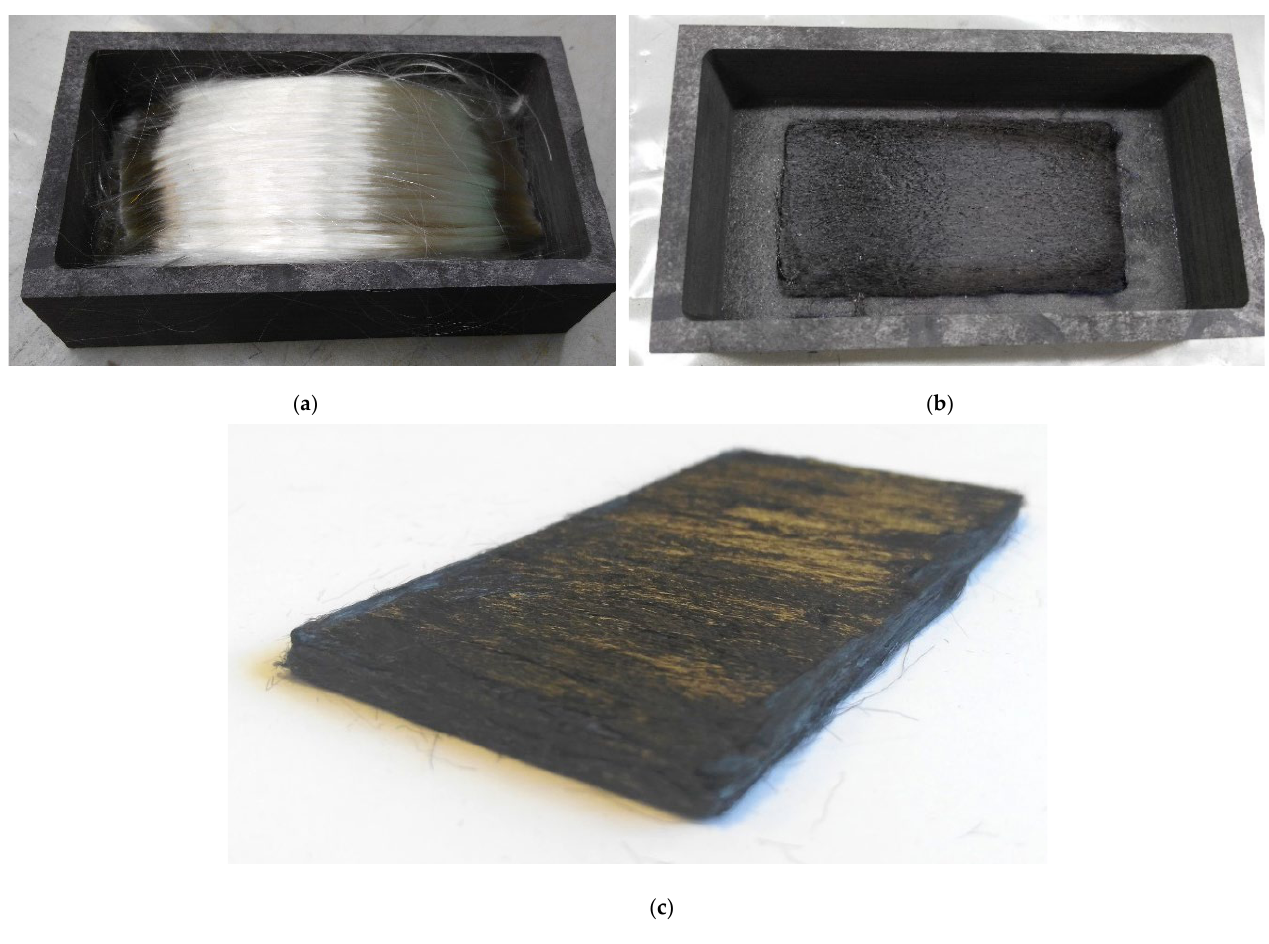
Figure 12. OP-SiC: ( a ) unidirectional PCS tape in a container before pyrolysis; ( b ) SiC frame, 90 × 45 × 4 mm in size, reinforcement scheme 0 ° /0 ° [1]; and ( c ) SiC frame, 90 × 45 × 3.5 mm in size, reinforcement scheme 0 ° /90 °.